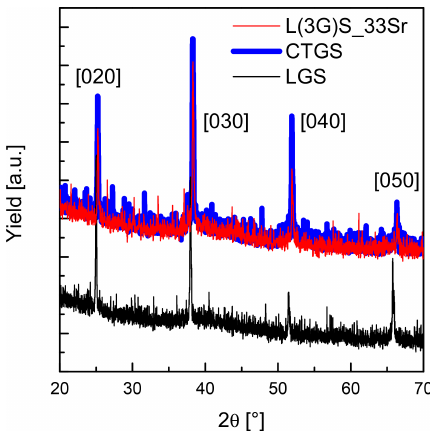
Figure 5. XRD pattern of a film grown on a CTGS single crystal using the L(3G)S_33Sr target (red) and diffraction patterns of un- coated CTGS (blue) and LGS (black) single-crystalline substrates. Figure 6. Electrical conductivity of the Sr-doped thin film (pre-